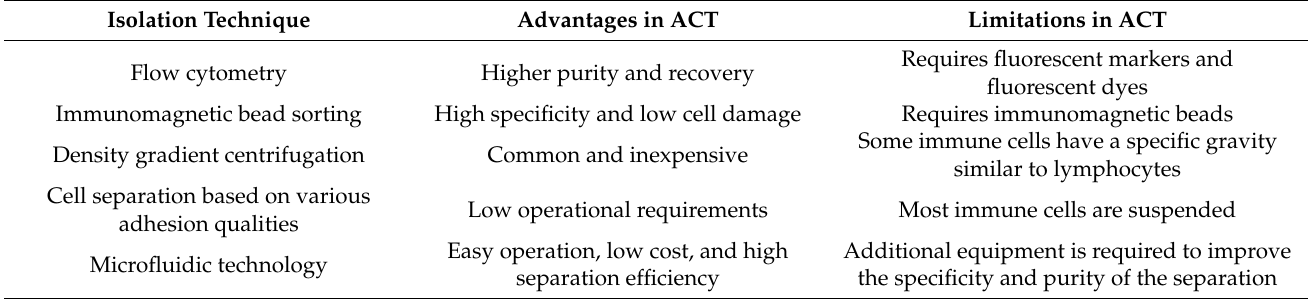
Table 1. Summary of cell isolation techniques.